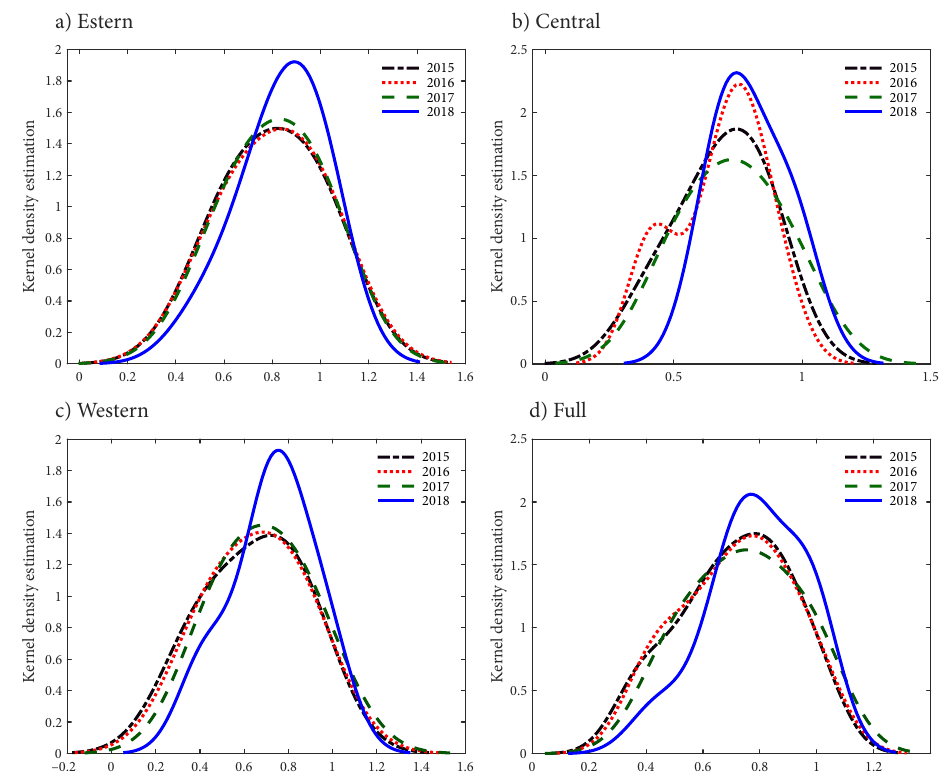
Figure 3. Kernel density curve of national, Eastern, Central, and Western Regions Table 5. Overall efficiency from 2015 to 2018 of the Eastern, Central, and Western regions